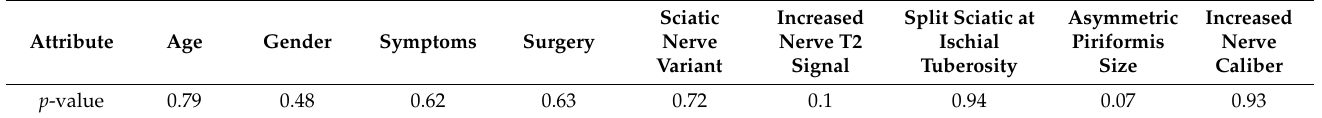
Table 2. Statistical significance of the difference between the MR images acquired at 1.5 T and 3.0 T for pertinent study